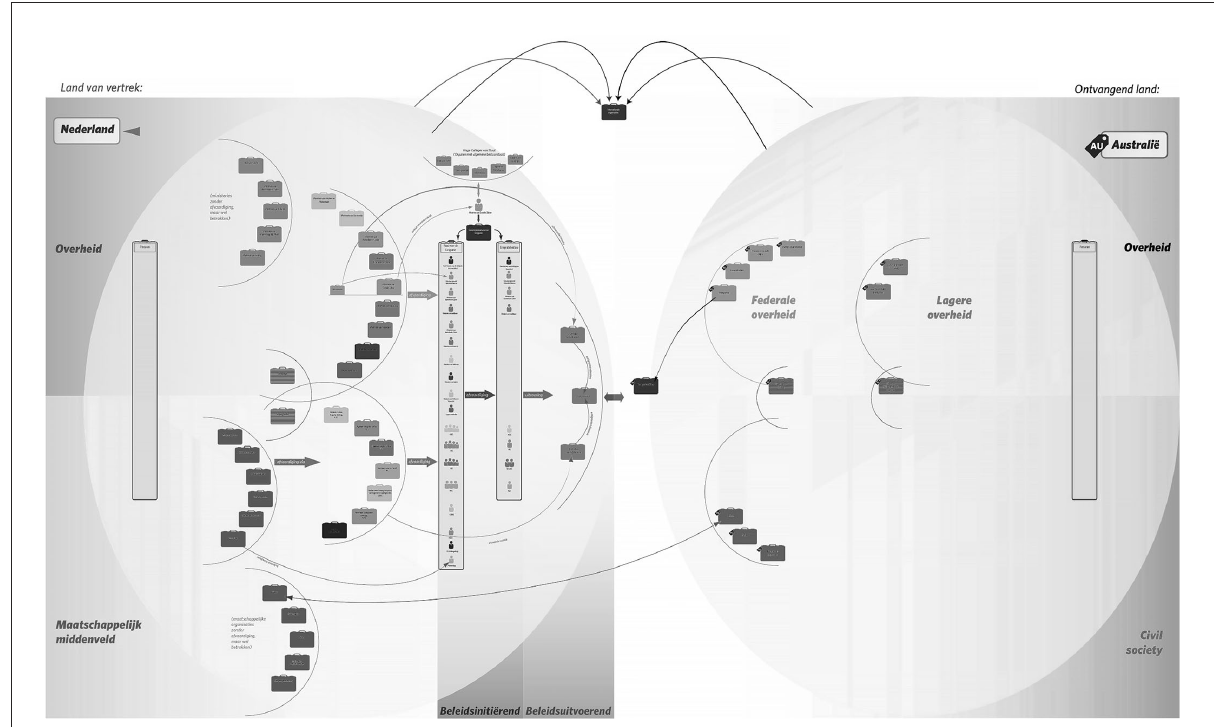
FIGURE1 Schematic overview of actors and archives involved in Dutch post-world War II